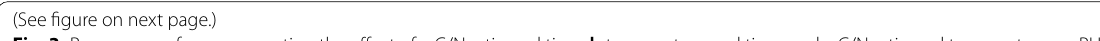
productivity(See figure on next Fig. 3 Response surface representing the effect of a C/N ratio and time, b temperature and time, and c C/N ratio and temperature on PHB